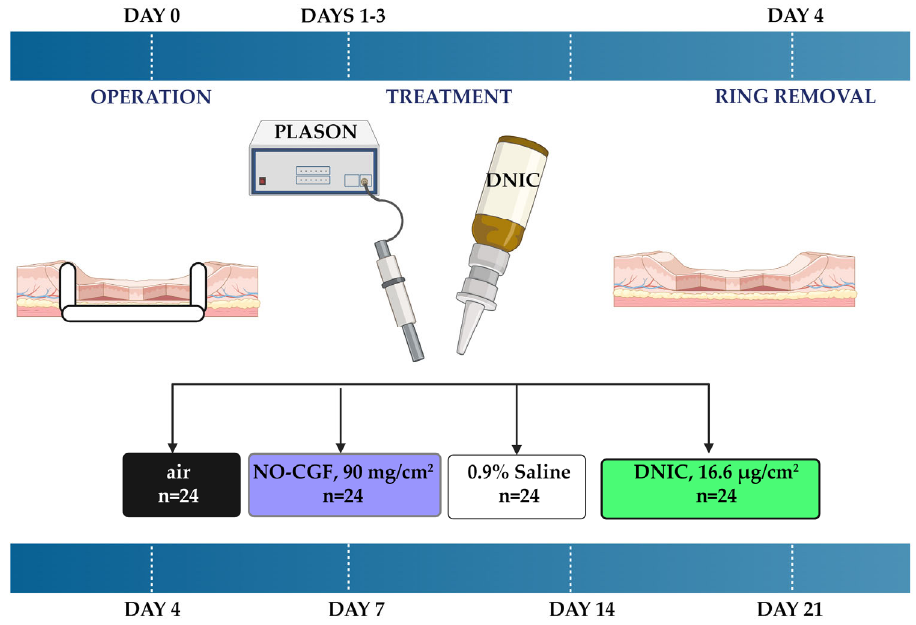
Figure 20. Experimental design (created using